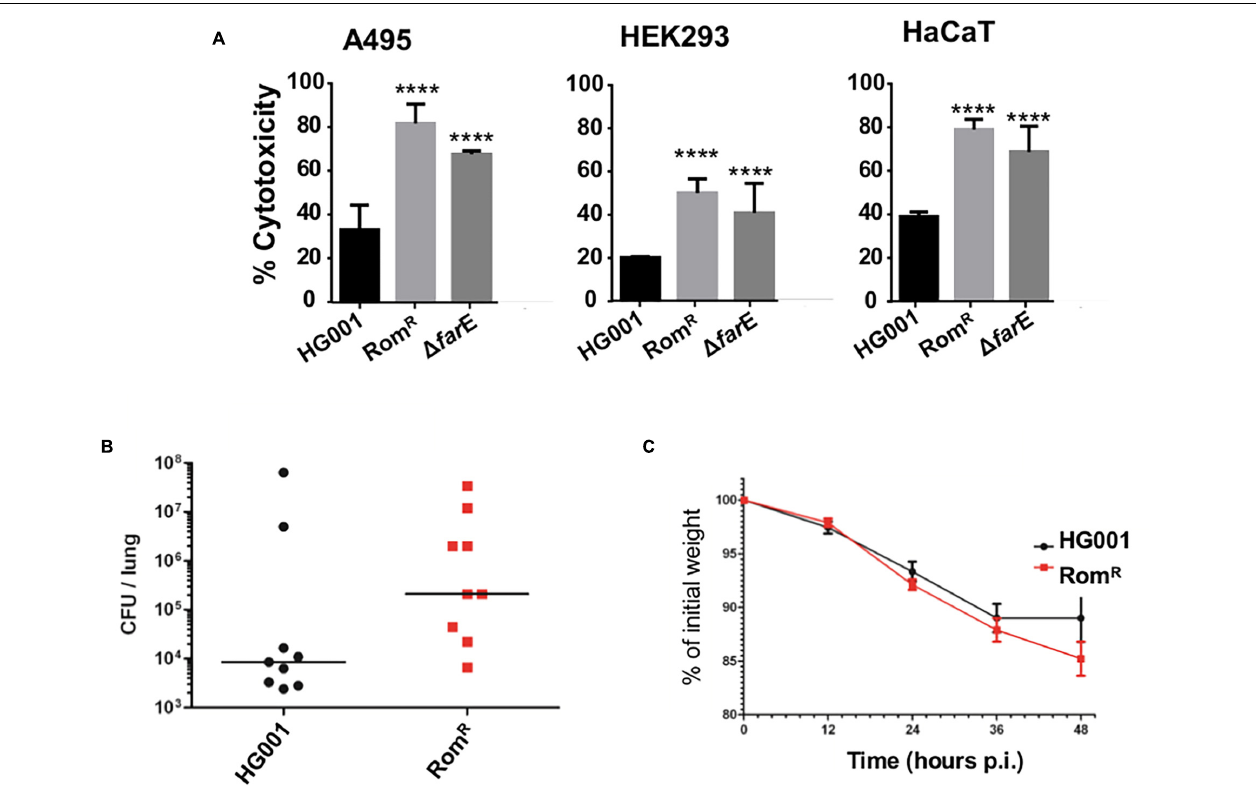
FIGURE 5 | Comparison of cytotoxicity and mouse pathogenicity. (A) Comparison of the cytotoxicity of HG001, Rom R clone, and Rom R (cid:49) farE mutant in various host cells A495, HEK, and HaCaT. Experiments were performed in triplicate. Error bars indicate standard error. Statistical significances between mutant clones Rom R , (cid:49) farE (Rom R (cid:49) farE ) with the wild type HG001 were analyzed by 1-way ANOVA: not significant P > 0.05, ∗ P < 0.05, ∗∗ P < 0.01, ∗∗∗ P < 0.001, ∗∗∗∗ P < 0.0001. (B,C) Comparison of HG001 and Rom R clone in 48 h intranasal mouse infection model (pneumonia model). The Rom R clone shows higher CFU values in the lungs after 48 h of infection (B) , and a slightly stronger weight loss than the wild type HG001 (C) . Significant differences ( ∗ P = 0.0313) in bacterial burden were noted between Rom R and the wt HG001. Data were analyzed using Mann–Whitney one tailed test.